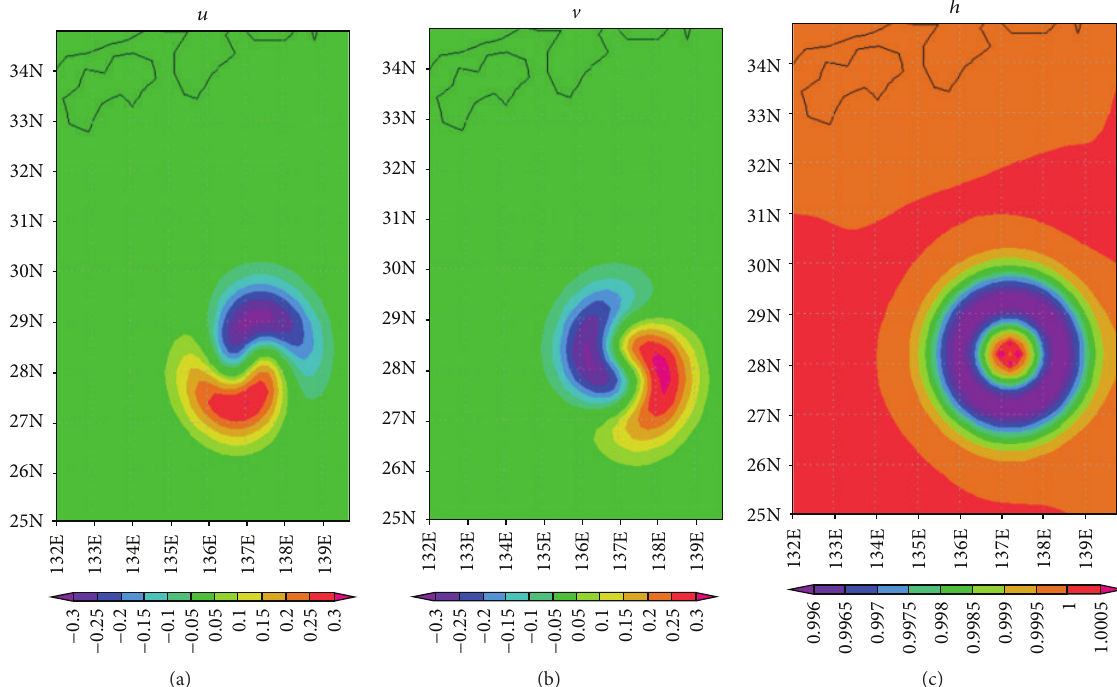
Figure 5: The figures show the values of the zonal velocity 𝑢 , the meridional velocity V , and the layer thickness ℎ after a time integration of 8 hours.